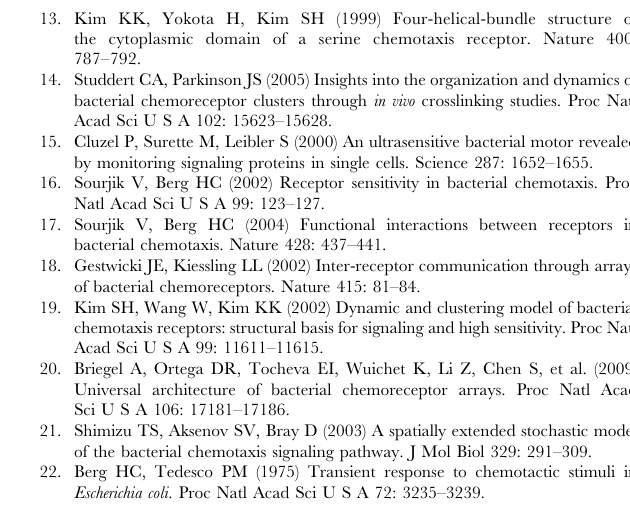
Figure S1 2-D random walk. Overview of the running model, with movable agents representing soluble proteins as circles, and immobile agents representing receptors as hexagons. Found at: doi:10.1371/journal.pone.0009454.s001 (5.13 MB TIF) Figure S2 The class structure of agents in Chemoscape. At the top level is the protein agent, which implements behavior general to all protein agents, such as the ability to move stochastically and to interact with other proteins. Below that are the individual protein types. Each class implements behaviors specific to that protein type. For example, CheY can be phosphorylated, and can interact with CheA. The ‘‘receptor’’ type is a special subclass that is rendered immobile, and implements several subclasses for each of the major chemotaxis receptor